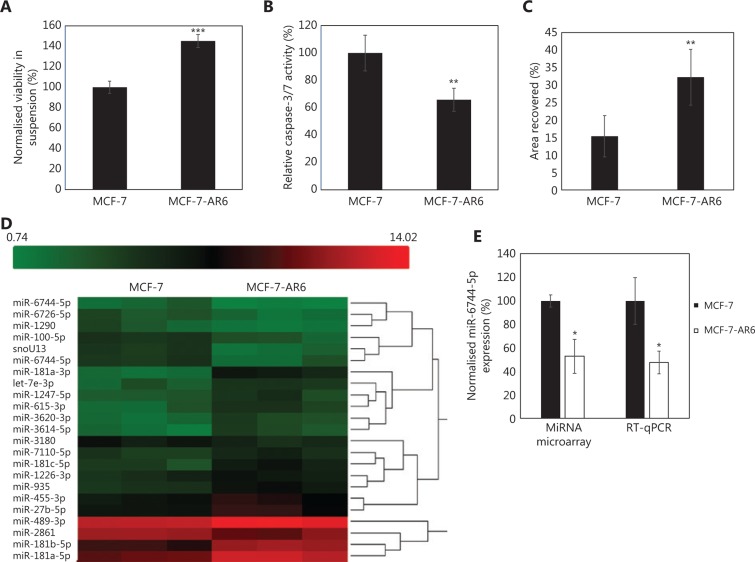
Downregulation of miR-6744-5p in anoikis resistant MCF-7-AR6. Comparison of MCF-7 and MCF-7-AR6 by measuring (A) viability after 48 h in suspension, (B) caspase-3/7 activity after 24 h in suspension and (C) scratch area recovery in wound healing assay after 24 h. (D) Hierarchical cluster heat map of miRNAs that are differentially expressed in MCF-7-AR6 when compared to the parental MCF-7. Red and green spectrum is used to represent signal strength, with red denoting high and green denoting low signal. The Affymetrix Transcriptome Analysis Console v3.0 was used to analyze the results using one-way between-subject analysis of variance (ANOVA), with ANOVA P-value < 0.05, and fold change >2.5 or <−2.5. (E) Downregulation of the selected miRNA, miR-6744-5p, was validated with reverse transcription-quantitative polymerase chain reaction (RT-qPCR). Data are presented as mean ± standard deviation (SD), and statistically significant differences compared to respective controls are denoted by (*) for P < 0.05, (**) for P < 0.01 or (***) for P < 0.001.